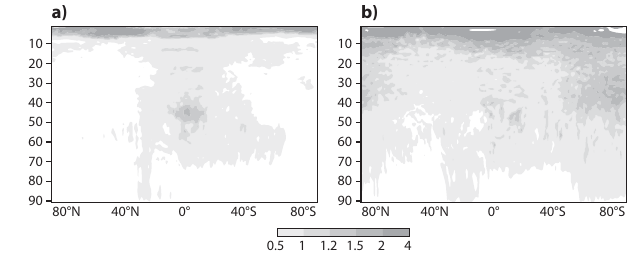
Figure 4. Zonally averaged cross section from 5 October 2008 to 15 November 2008 for the u component of the EDA spread. (a) Dif- ference in spreads between the OBS-EDA and the OBS-OBS-EDA spreads, (b) difference between the XB-EDA and the OBS-EDA spreads. Vertical coordinate is model level. Contours in ms − 1 .